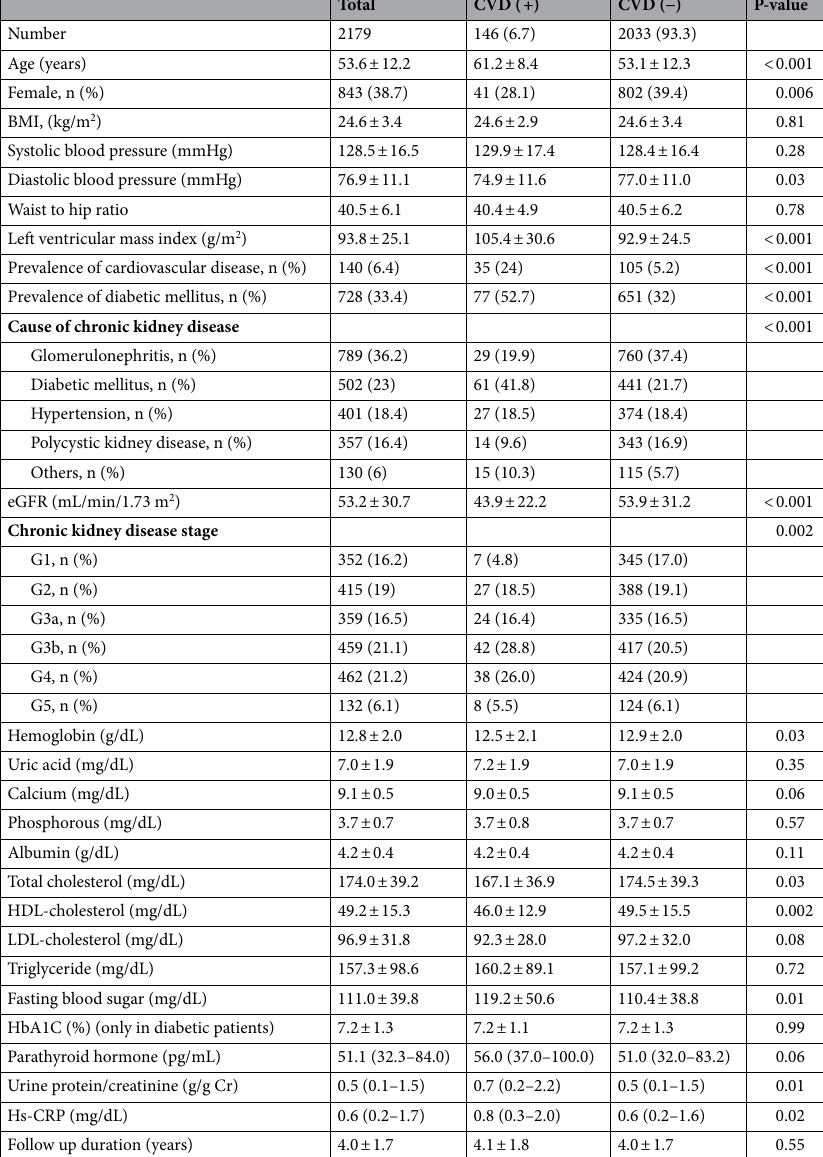
Table 2. Comparison of baseline clinical characteristics at enrollment with respect to the occurrence of cardiovascular disease. BMI body mass index, CVD cardiovascular disease, eGFR estimated glomerular